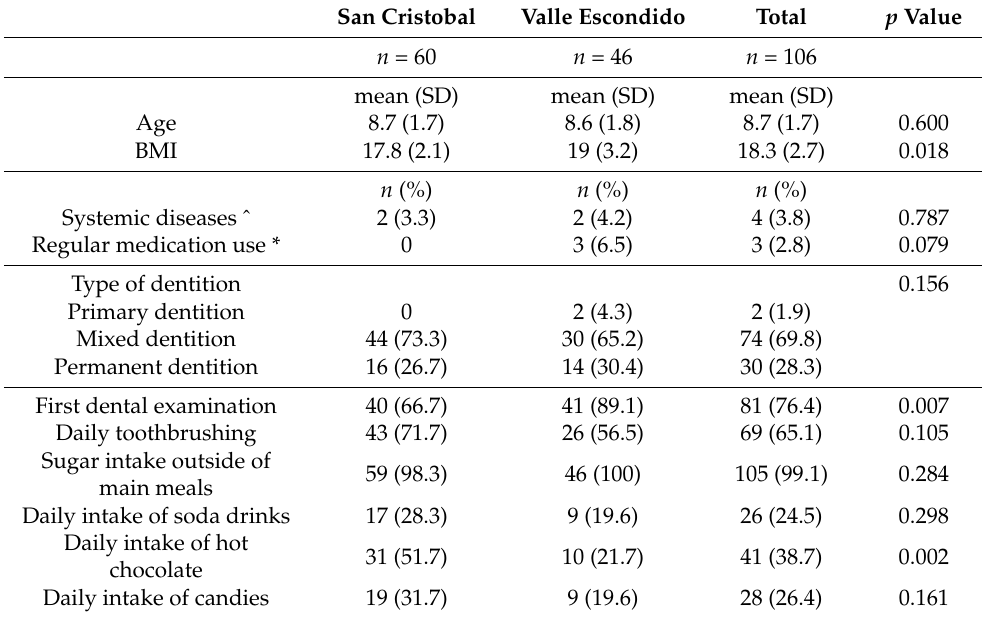
Figure 1. Flow chart of selection of included participants. Table 1. Population characteristics.